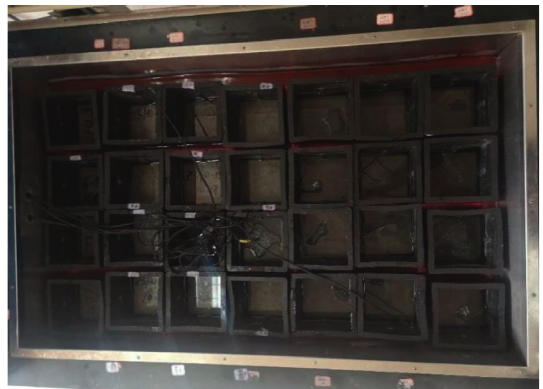
Figure 3: Rapid freezing-thawing machine for